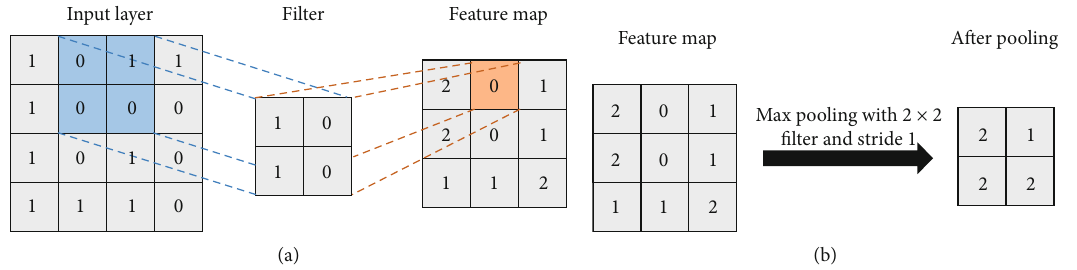
Figure 3: The unique neural network layers in CNN: (a) convolution and (b) pooling layers.